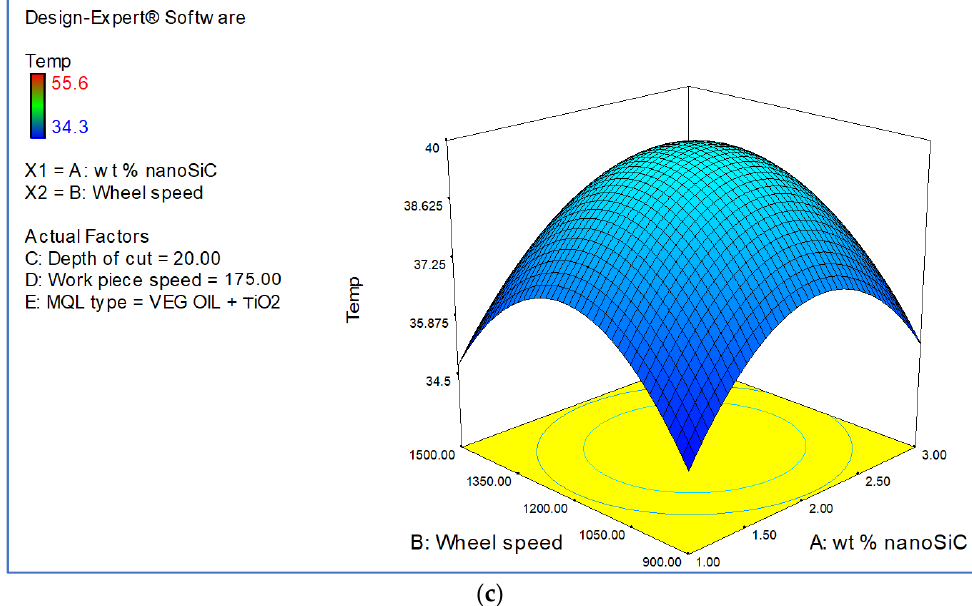
Figure 9. ( a ) 3D response plot for TEMP on wt % of nano-SiC vs. wheel speeds under SAE20W40. ( b ) 3D response plot for TEMP on wt % of nano-SiC vs. wheel speed under veg oil. ( c ) 3D response plot for TEMP on wt % of nano-SiC vs. wheel speed under veg oil + TiO 2 .